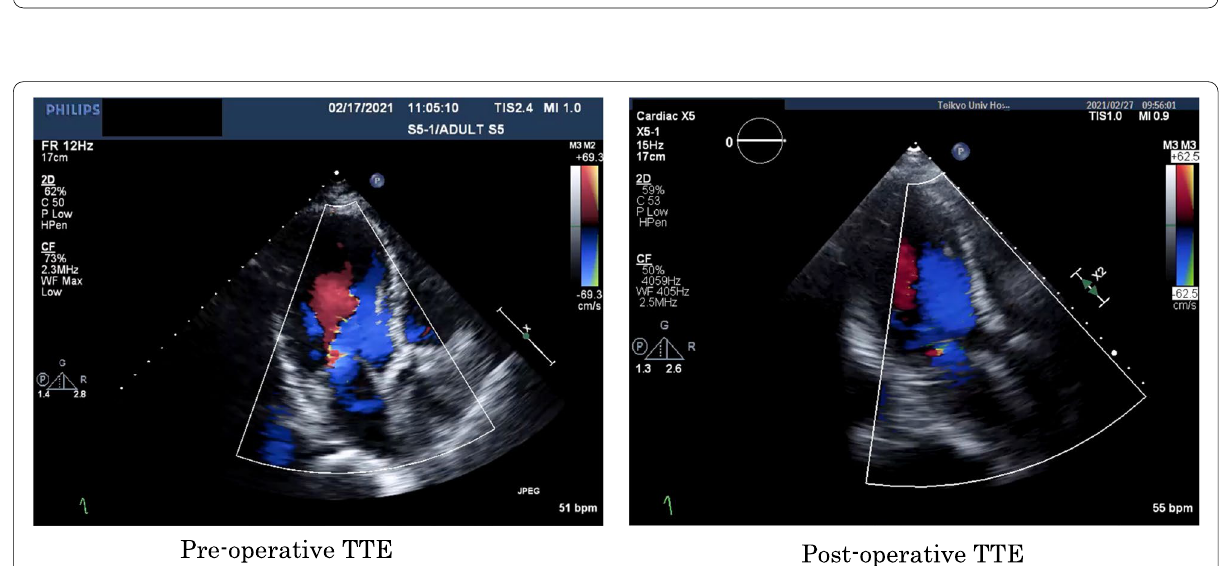
Fig. 3 Intraoperative transesophageal echocardiography (TEE) (post-deploy). Movie. In systolic period, central regurgitation flow was detected in indentation of mitral valve with color Doppler mode. Left side view showed mid-commissural view. Regurgitant flow of different time phases are shown. LV long axis view. Vena contracta was 4.0mm. This semi-quantification revealed mild to moderate regurgitation